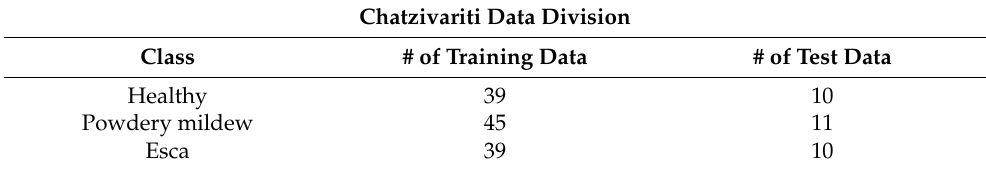
Table 6. Data division into training and test set for the three classes of the Chatzivariti study case. Chatzivariti Data